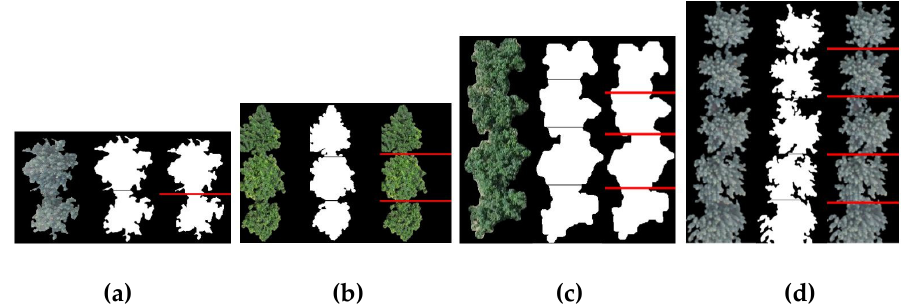
Figure 16. Segmentation results of canopies based on the proposed method: ( a ) two interweaving trees; ( b ) three interweaving cherry trees; ( c ) four interweaving cherry trees; and ( d ) five interweaving apple trees. Each group, from left to right: original images, segmentation result, and the ground truth.